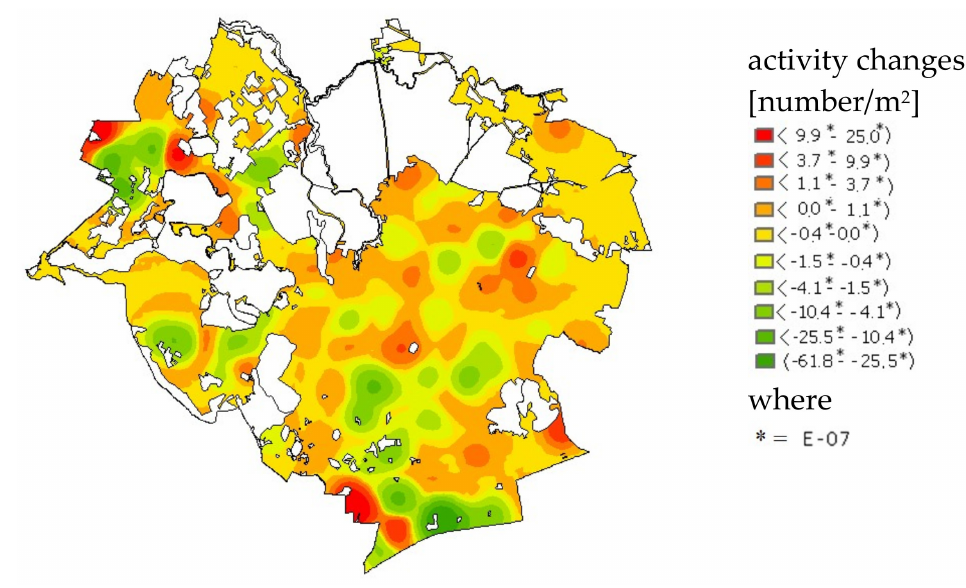
Figure 11. Diversity of the spatial activity dynamics on the local real estate market.